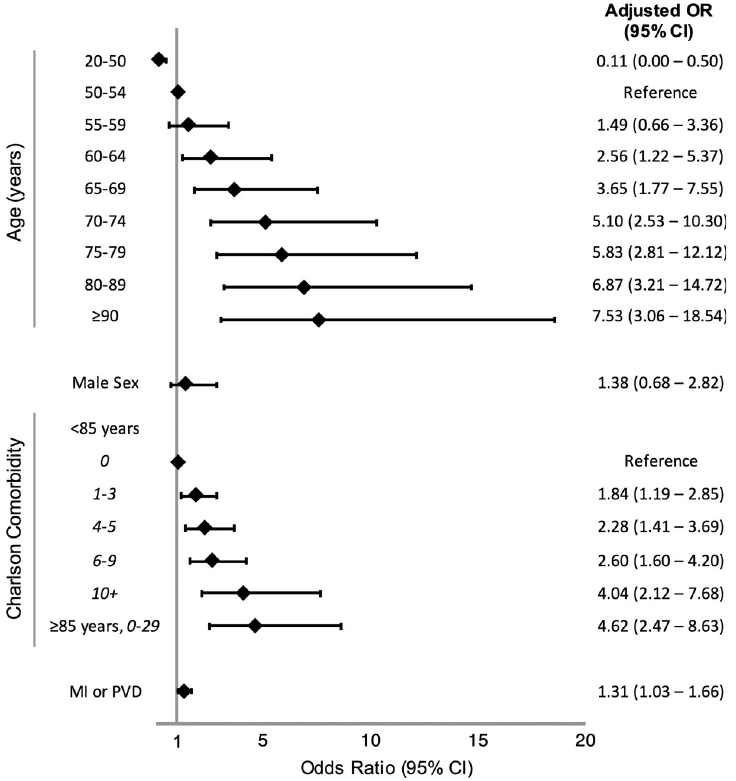
Fig 2. Forest plot of VACO Index 30-day mortality multivariable model. Forest plot of odds ratios (OR) and 95% confidence intervals (CI) of VACO Index variables from multivariable logistic regression model derived from development cohort (n = 3,681). Abbreviations: MI or PVD = history of myocardial infarction or peripheral vascular disease.